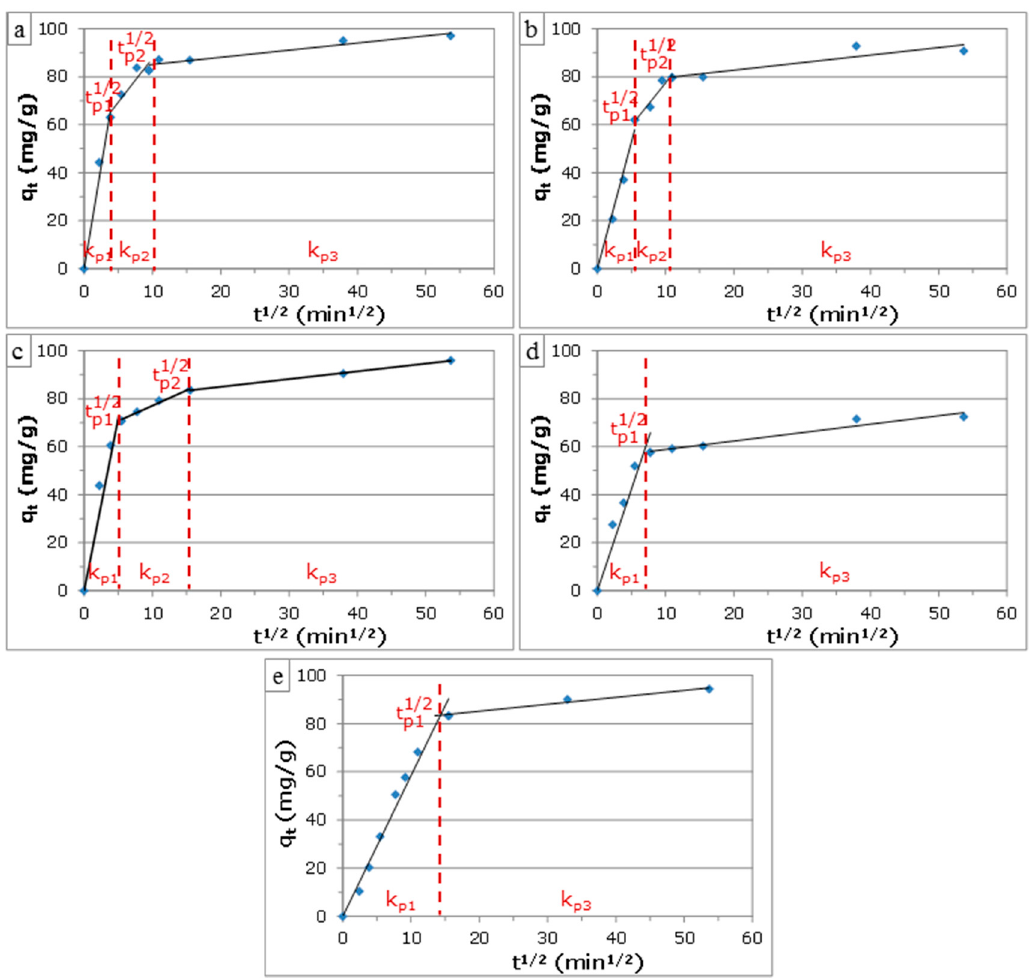
Figure 8. Plots of the intraparticle diffusion (IPD) model for phenol adsorption on selected ACs: ( a ) RBC-S-900-90; ( b ) RBC-C-900-120; ( c ) RSC-S-900-90; and ( d ) RSC-C-900-120; compared to commercial AC ( e ). Table 6. IPD model constants and correlation coefficients for the adsorption of phenol on selected ACs derived from RSC and RBC, compared to commercial AC.